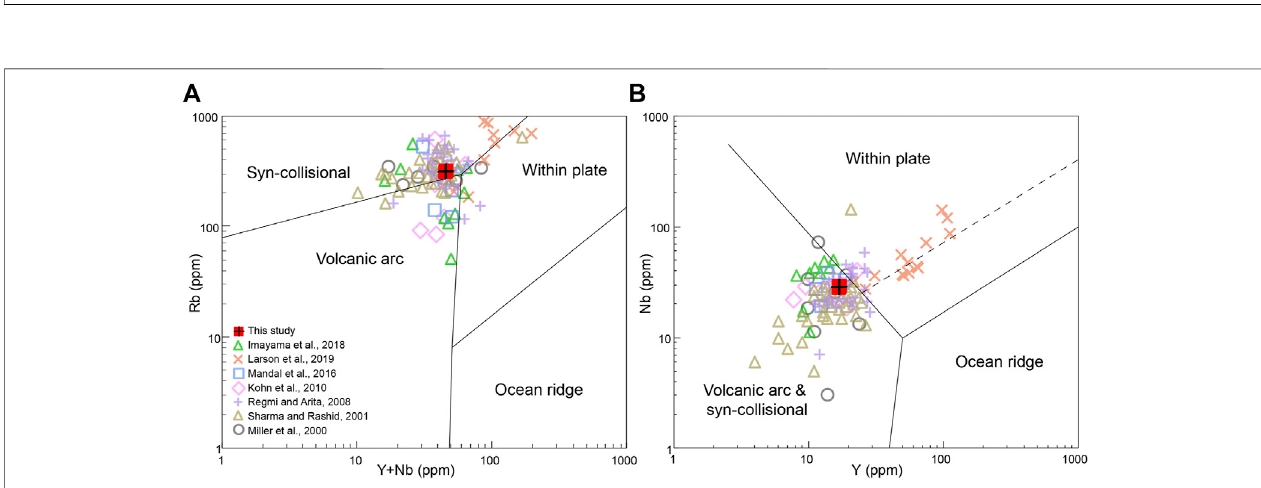
FIGURE10| Tectonicdiscriminationdiagrams. (A) Y+Nbvs.Rbdiagramand (B) Nbvs. Ydiagram,after thestudybyPearceetal.(1984)andPearce(1996).The dashed line represents the upper compositional boundary of oceanic ridge granites from anomalous ridge segments. Data from Imayama et al. (2018), Larson et al. (2019), Mandal et al. (2016), Kohn et al. (2010), Regmi and Arita (2008), Sharma and Rashid (2001), Miller et al. (2000), and this study.